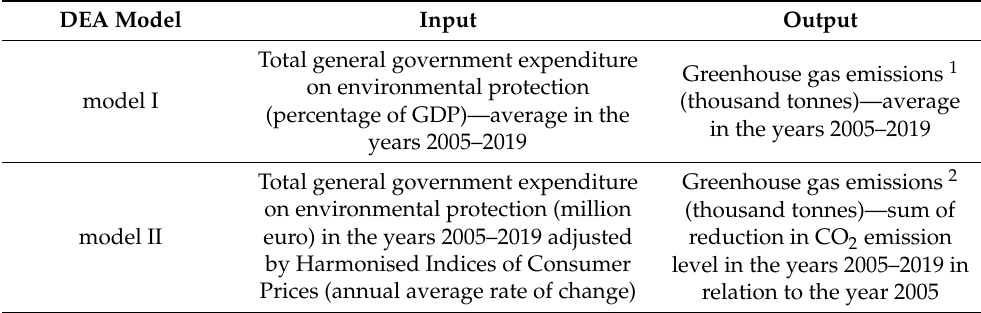
Table 2. Measures of inputs and outputs used in DEA